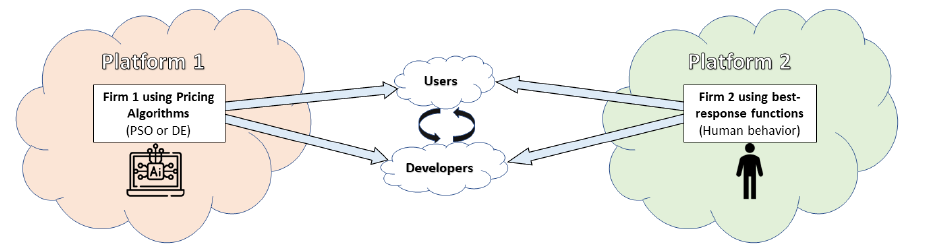
Figure 1. Algorithms, platforms, and relationships in this model. Source: Own and